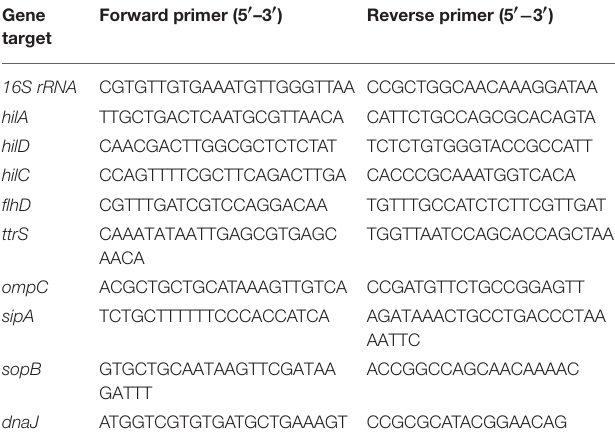
TABLE 4 | Primers used for RT-qPCR